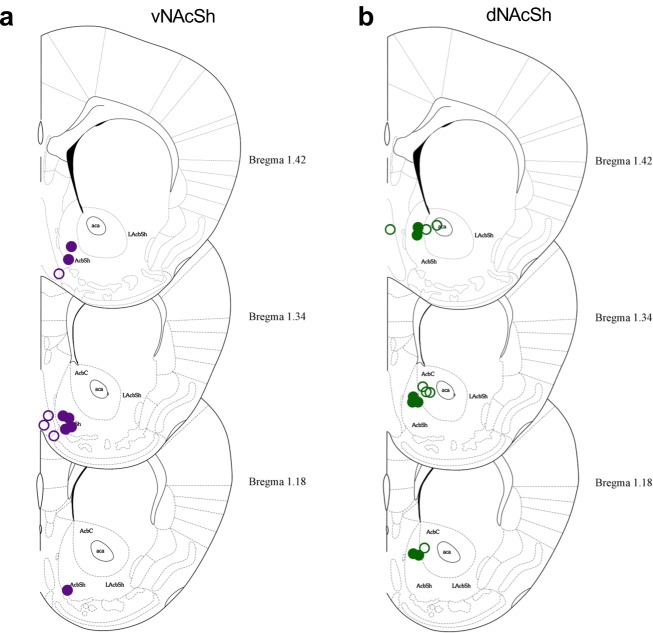
Hits maps showing placement of opto-dialysis probes (a) vNAcSh, closed purple circles represent correct hits, open circles represent misses.(b) dNAcSh, closed green circles represent correct hits, open circles represent misses.